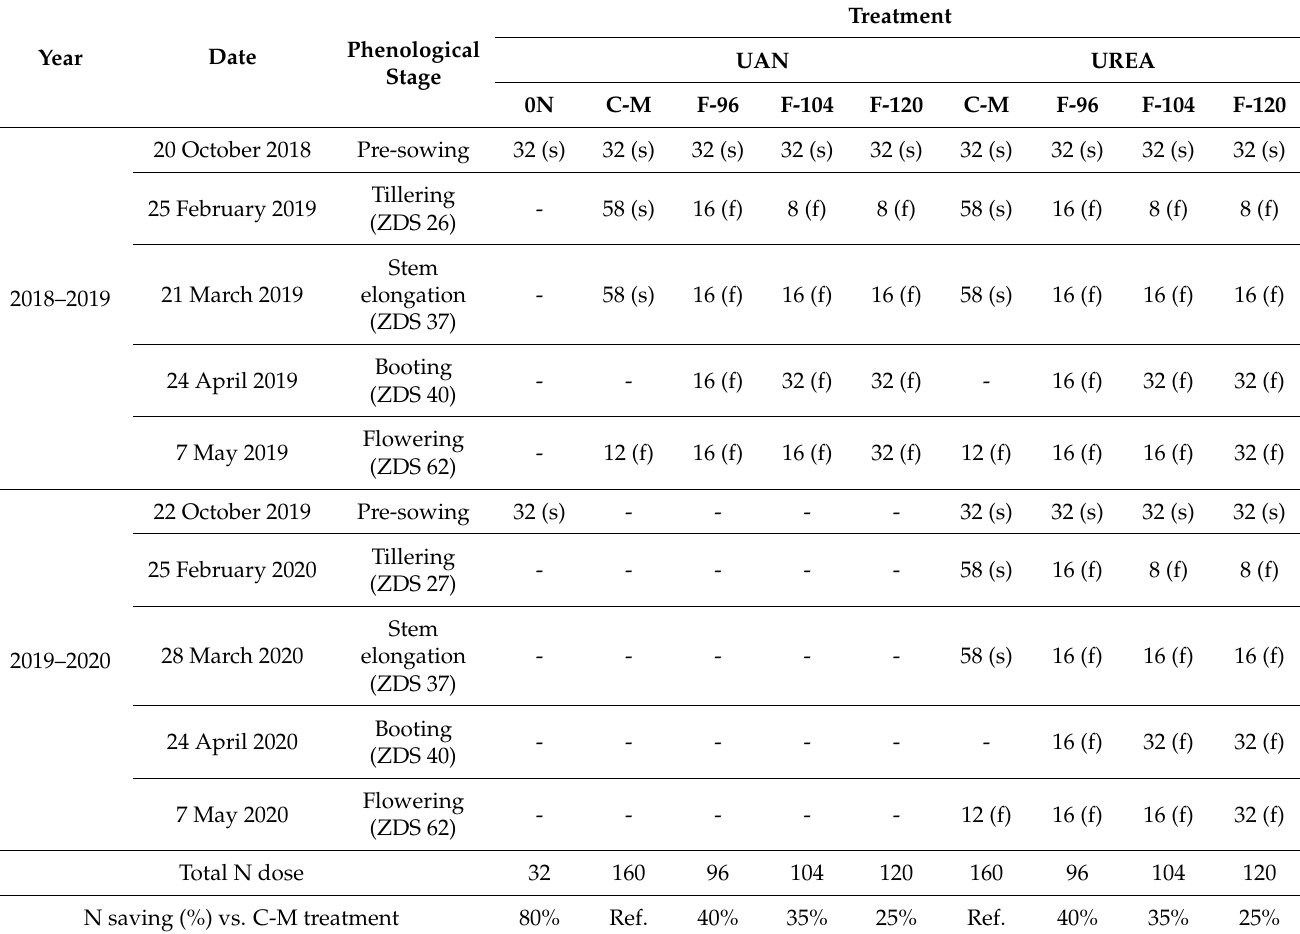
Table 1. Dates and growth stages of N application (kg ha − 1